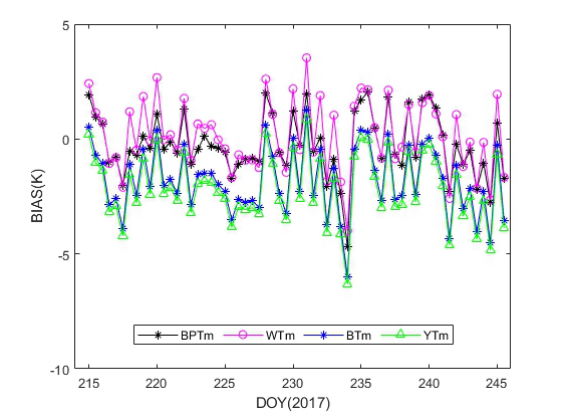
Figure 8.The bias of different models tested using radiosonde data from 2017 in Wuzhou